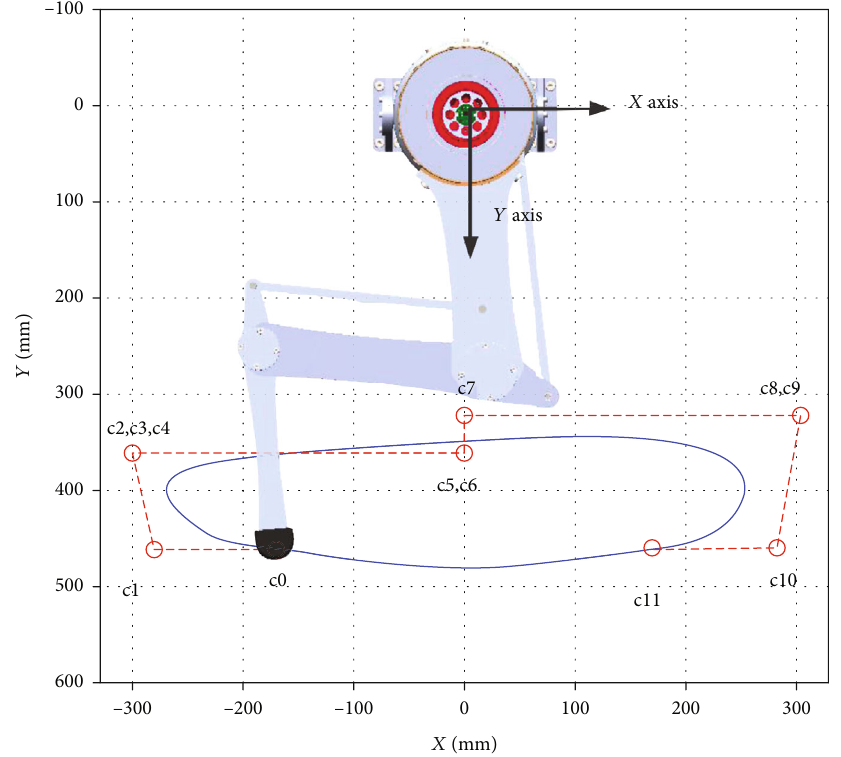
Figure 6: The desired trajectory decided by 12 control points of the Bézier curve.